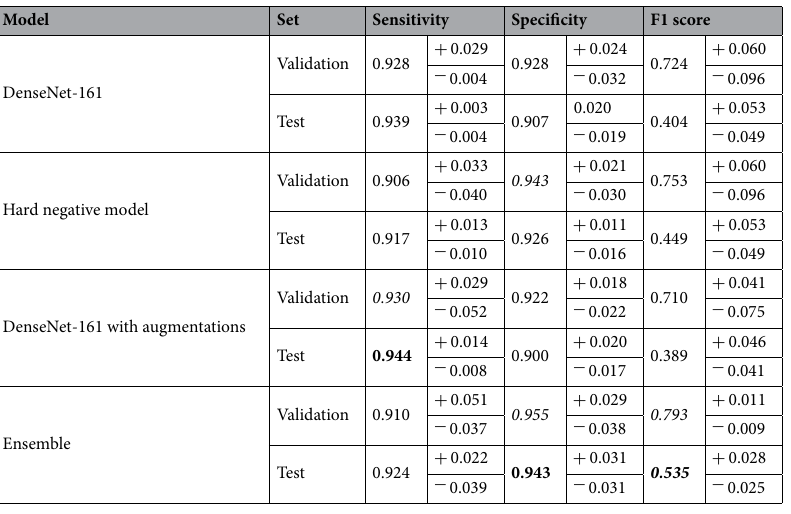
Table 1. 3-fold averaged results for the DenseNet-161 model, the hard negative mining model and the DenseNet-161 with augmentations model, with reported mean sensitivity, specificity and F1-scores averaged across all three folds. The highest score for a metric is highlighted in bold for the test set, whereas this is italicised for the validation set. Plus/minus values shows the mean subtracted from the highest and lowest results from the 3-fold experiments, for each